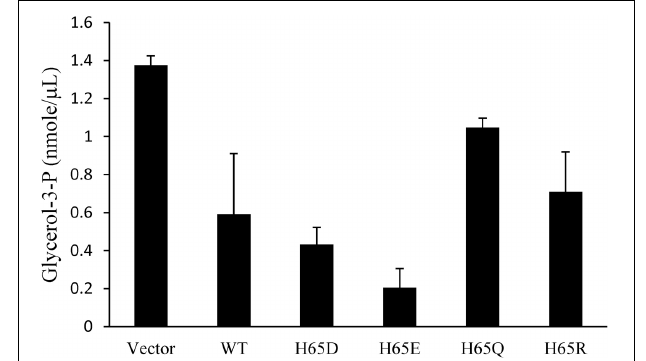
FIGURE 6 | Effects of KPN00353 overexpression on intracellular glycerol-3-phosphate concentration. We quantified the concentration of glycerol-3-phosphate (glycerol-3-P) in K. pneumoniae containing pBAD33 (Vector), K. pneumoniae containing pBAD33::Histaq353WT (WT), K. pneumoniae containing pBAD33::Histaq353H65D (H65D), K. pneumoniae containing pBAD33::Histaq353H65E (H65E), and K. pneumoniae containing pBAD33::Histaq353H65Q (H65Q) or pBAD33::Histaq353H65R (H65R).